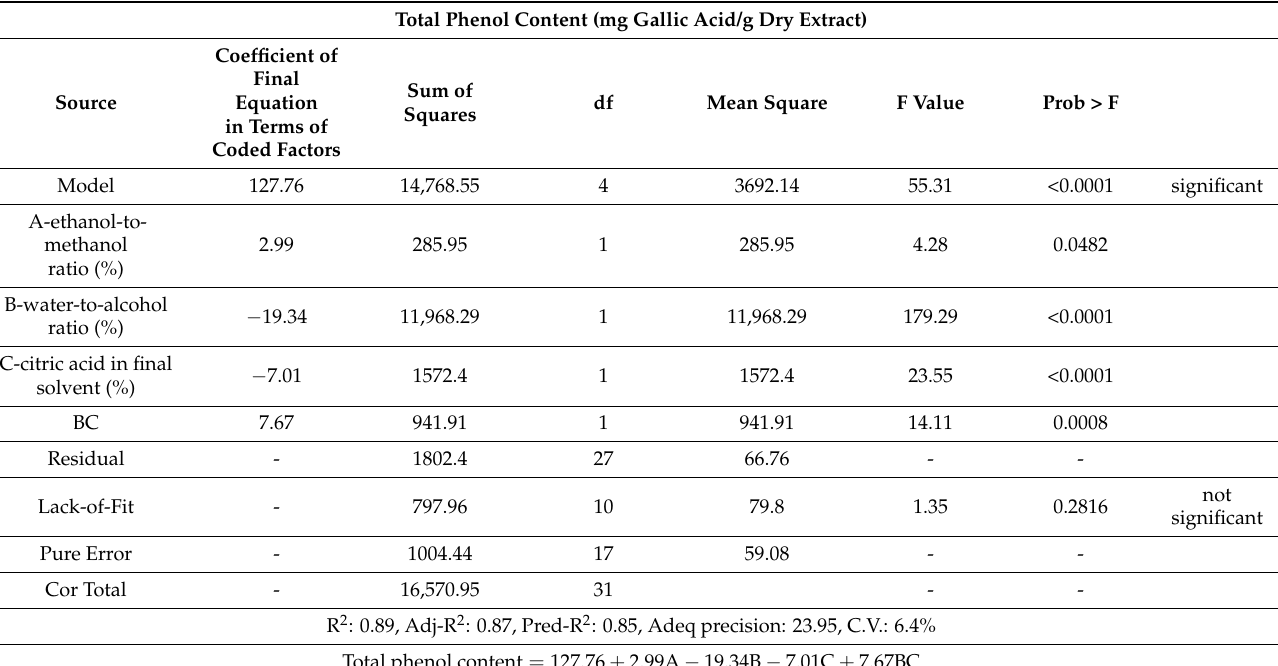
Table 2. The analysis of variance (ANOVA) of total phenol content (first-order fitted polynomial model) in bioactive compound extraction of eggplant peel by the different solvent